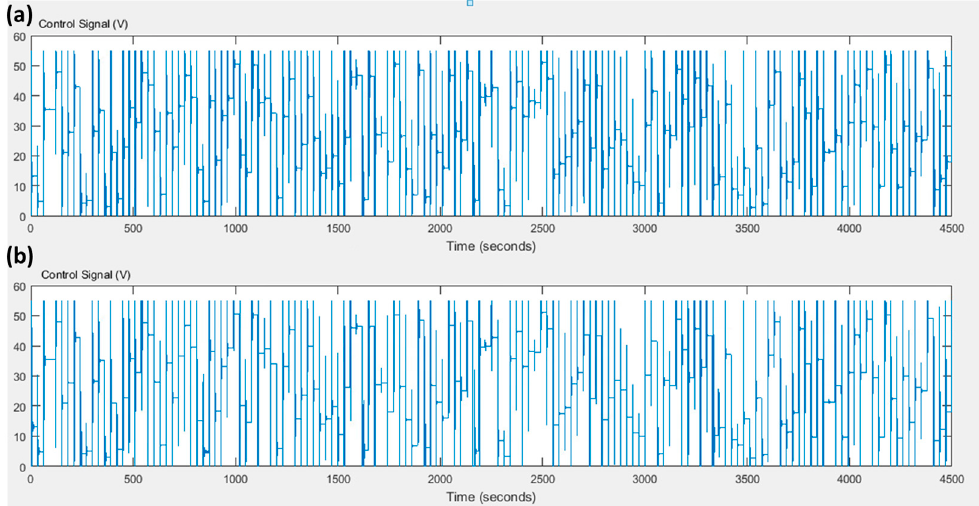
Figure 5. ( a ) Control signal of conventional PID control strategy and ( b ) control signal of fuzzy Q-Learning PID control strategy.